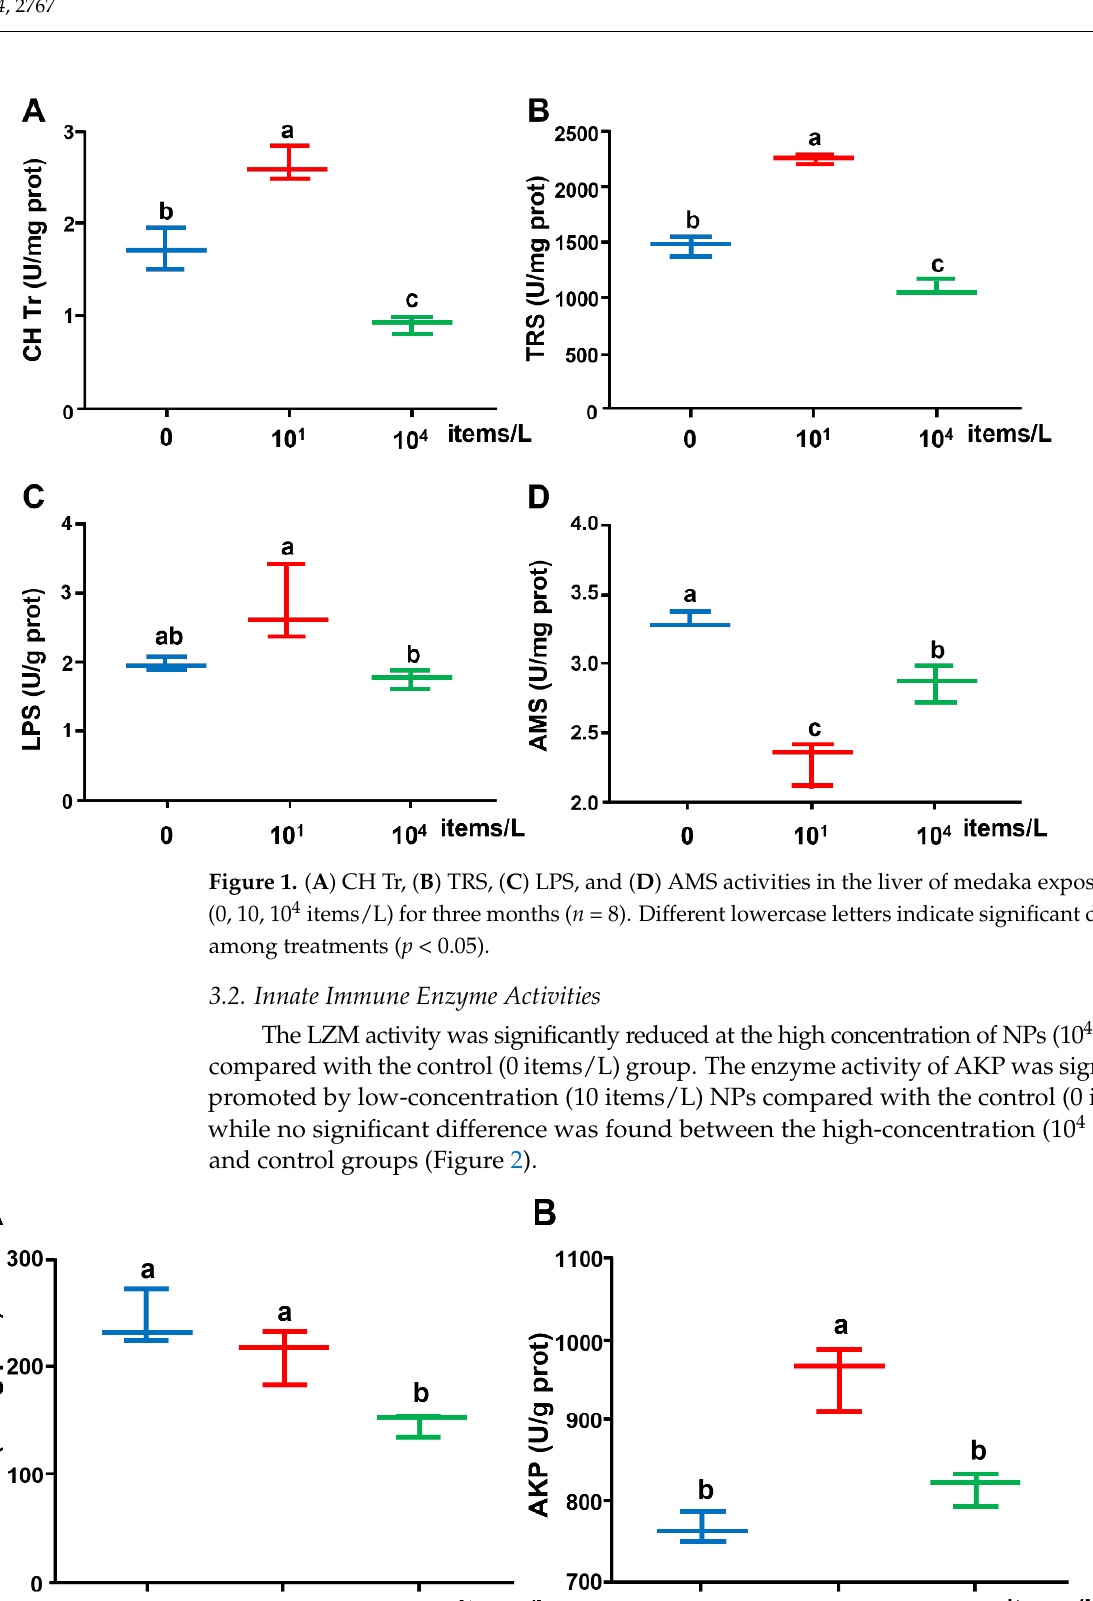
Figure 2. ( A ) LZM and ( B ) AKP activities in the liver of medaka exposed to NPs (0, 10, 10 4 items/L) for three months ( n = 8). Different lowercase letters indicate significant differences among treatments ( p <